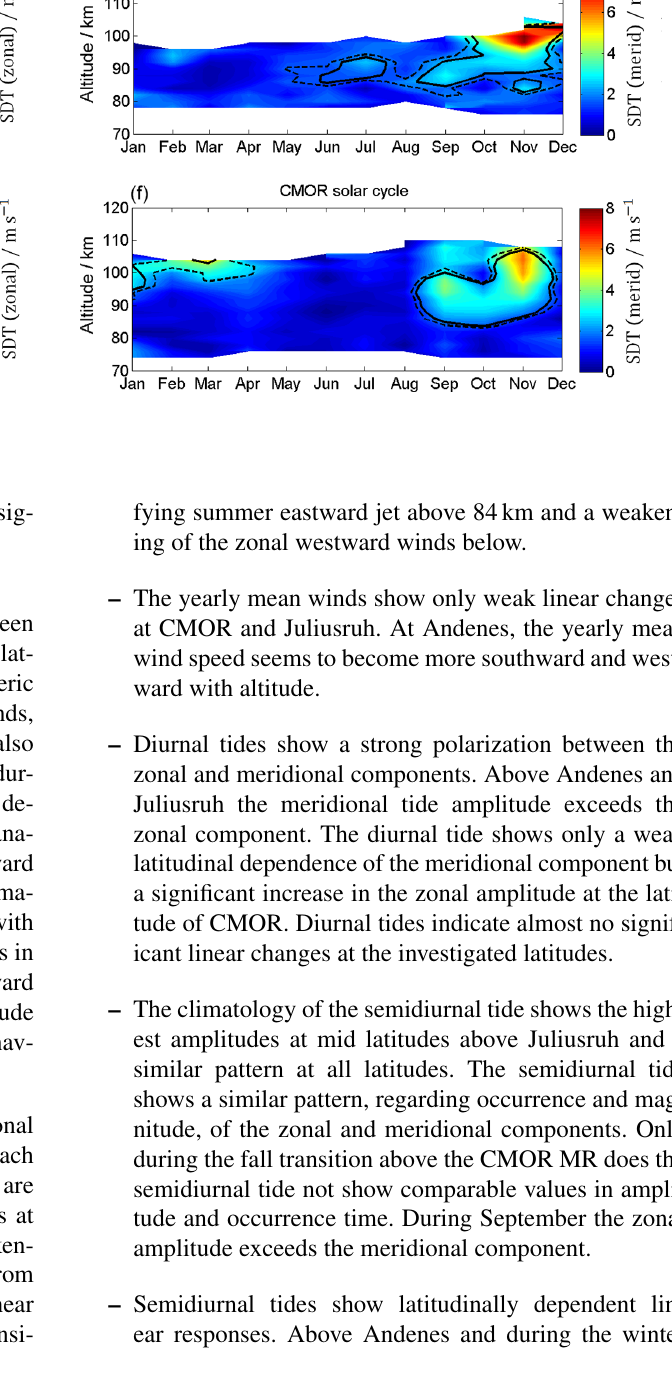
Figure 20. Same as Fig. 19 but for the semidiurnal component.